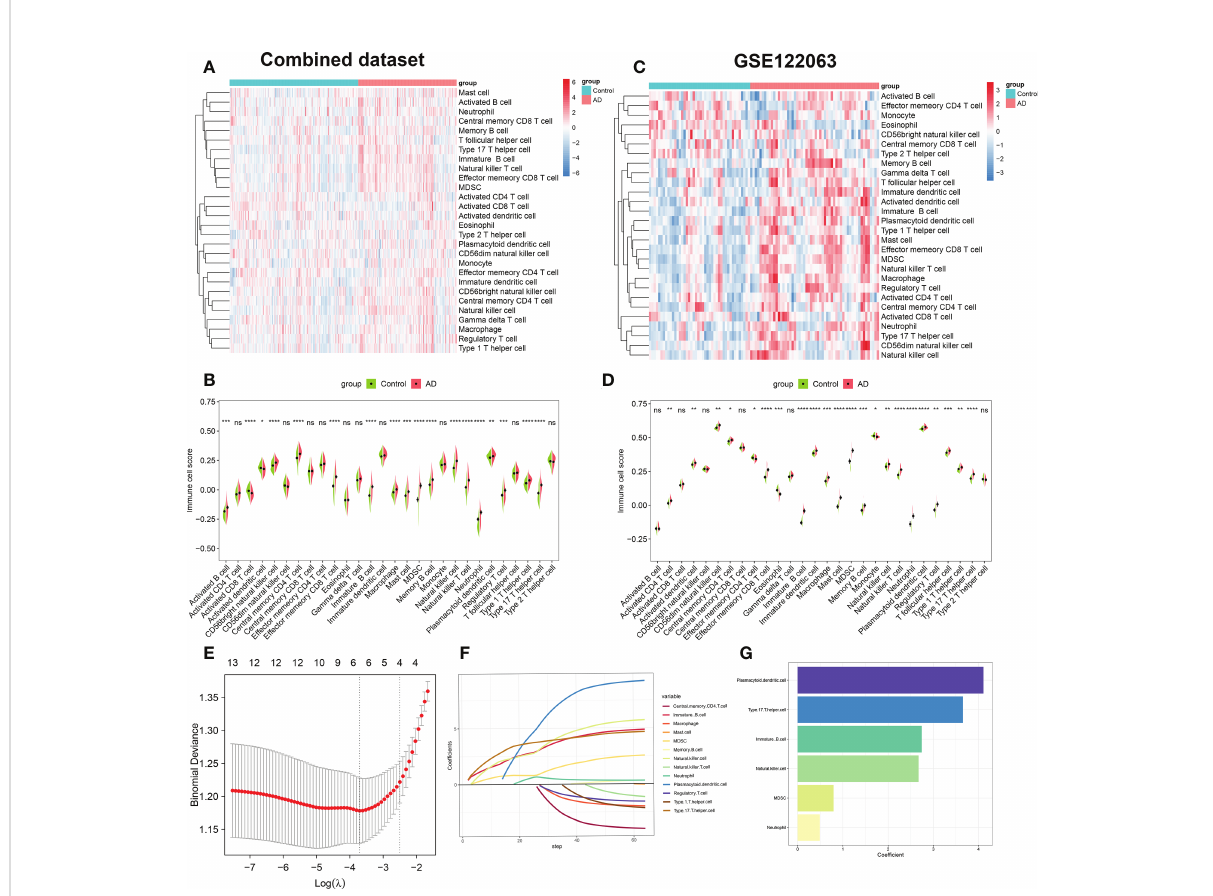
FIGURE 2 Evaluation of immune cell in fi ltration between AD and non-AD individuals. (A) Heatmap showing the ssGSEA scores of 28 immune cell subpopulations in combine dataset. (B) Violin plot showing the differences of in fi ltrated immune cells in combine dataset between AD and normal individuals. * p < 0.05, ** p < 0.01, *** p < 0.001, **** p < 0.0001, ns, no signi fi cance. (C) Heatmap showing the ssGSEA scores of 28 immune cell subpopulations in GSE122063. (D) Violin diagram showing the differences of in fi ltrated immune cells in GSE122063 between AD and normal individuals. * p < 0.05, ** p < 0.01, *** p < 0.001, **** p < 0.0001, ns, no signi fi cance. (E) Ten-fold cross-validation of LASSO regression analysis. Error bars represented the standard error (SE). The dotted vertical lines corresponded to the optimal value of lambda. (F) LASSO coef fi cient pro fi les of 13 differentially expressed immune cells. (G) Barplots showing six immune cells with non-zero coef fi cients recognized by LASSO